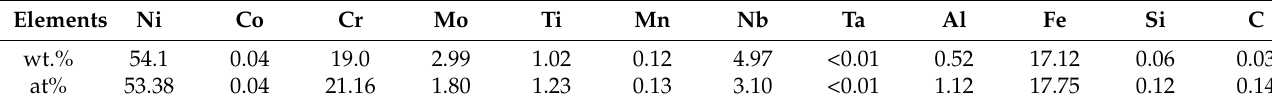
Table 1. Composition of Inconel 718 powder.